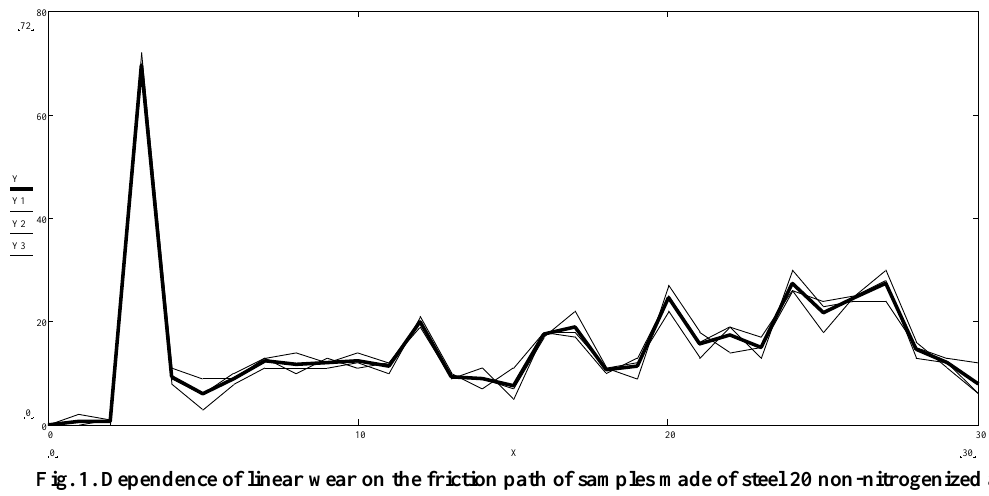
Fig. 1. Dependence of linear wear on the friction path of samples made of steel 20 non-nitrogenized at a pressure of 10 MPa, a speed of 1.8